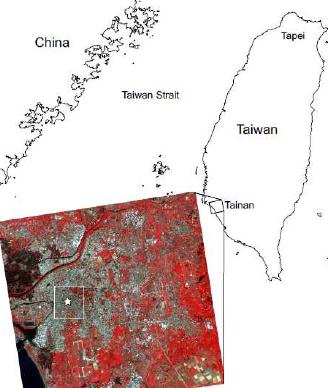
Figure 1. Location of the study area: Tainan City, Taiwan and Formosat-2 false color image. The star on Formosat-2 image represents the location of the meteorological station. The white rectangle is the area shown in Figures 3 and